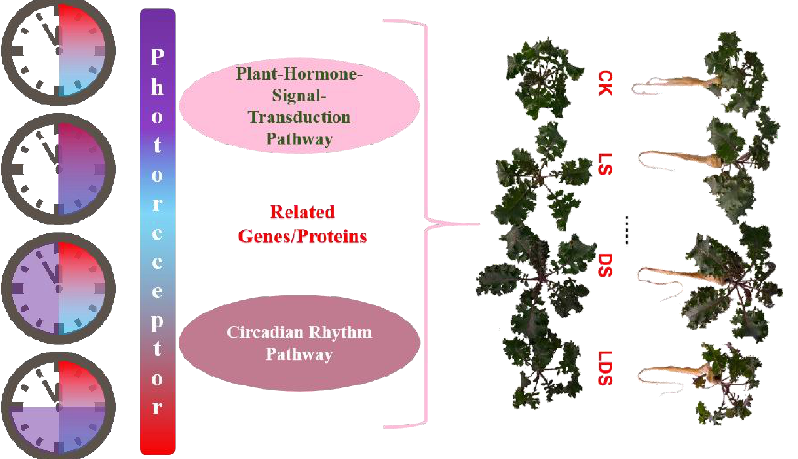
Figure 5. Key regulatory pathways/genes responded to different UV-A supplementation of kale. “LS” = Light-UVA Supplementation, “DS” = Dark-UVA Supplementation, “LDS” = Light/Dark-UVA